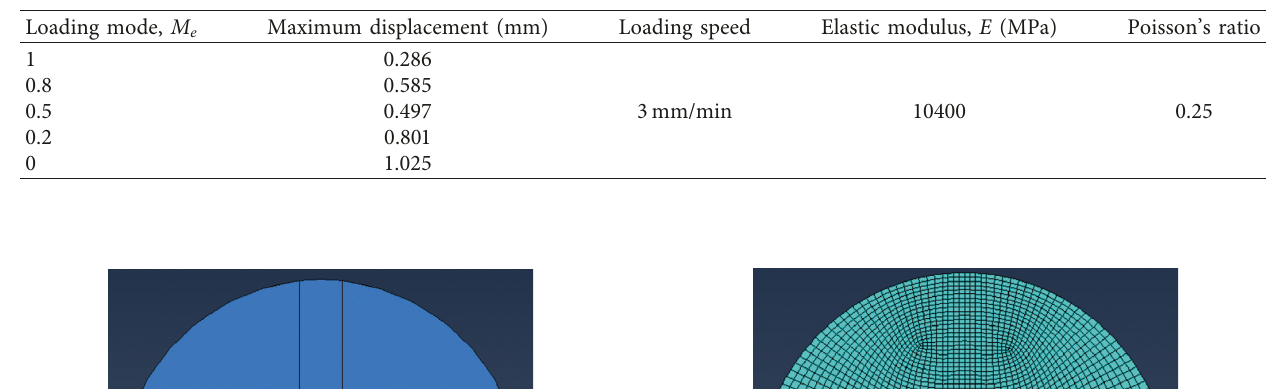
Table 5: Calculation parameters under different loading modes.